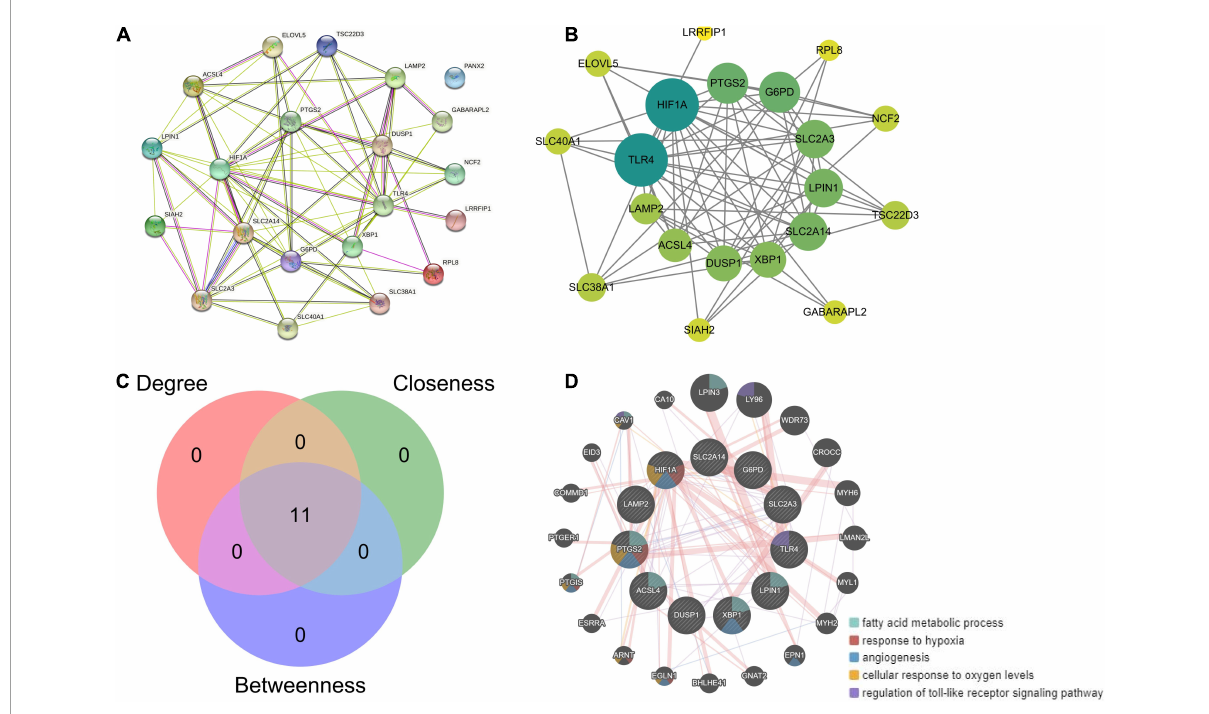
FIGURE7 Hub gene analysis. (A) Based on the 21 ferroptosis-related genes, a PPI network was generated based on the STRING online database. (B) Hub genes were analyzed using the plug-in cytoNCA. (C) The top 11 hub genes were identified by calculating the betweenness, closeness, and degree. (D) Enrichment analysis of 11 hub genes by GeneMANIA online